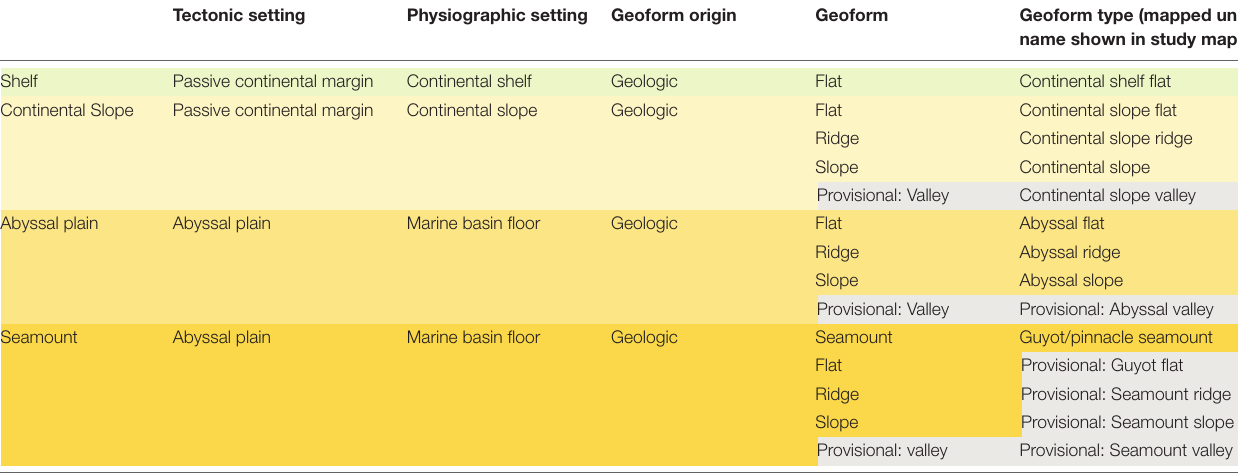
TABLE 1 | CMECS geoform classes mapped within the Atlantic Margin study area. Tectonic